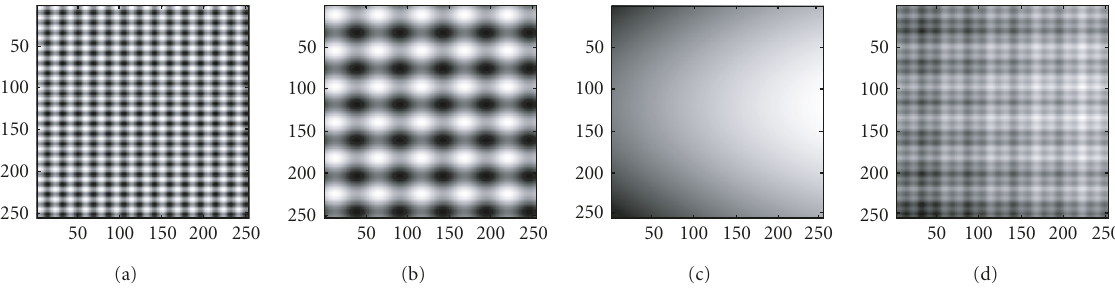
Figure 9: (a) Component 1 (STC-1), (b) component 2 (STC-2), (c) component 3 (STC-3), (d) original synthetic texture image (STI) obtained from addition of (a) to (c).